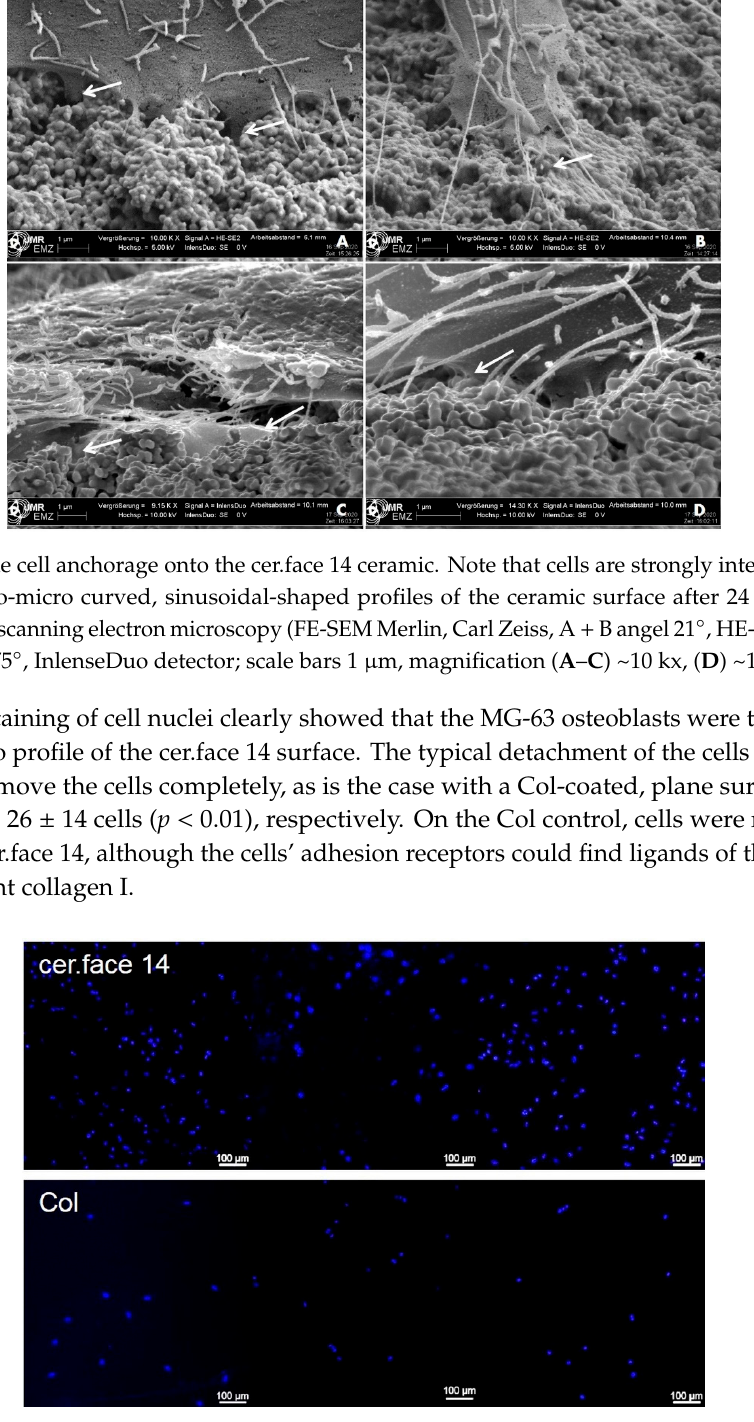
( b ) Figure 6. Reactive oxygen species (ROS): non/negligible stress level of osteoblasts on ceramic (cer.face 14), which is comparable with cells on the extracellular matrix protein collagen I (Col) ( a ) after 1 h, ( b ) after 24 h. Cells’ intracellular ROS level is ~9 times higher if stressed with H 2 O 2 as positive control. The amount of ROS in human osteoblasts MG-63 was detected via DCF-DA cellular ROS detection assay kit (Tecan Infinity 200). Statistics: one-way ANOVA posthoc uncorrected Fishers LSD, significance * p < 0.05, n = 3 (independent experimental approaches). Free intracellular ATP, as the universal energy carrier in the cells, also serves as an indicator of cellular stress. In order to further investigate possible cellular stress due to surface landscapes, the ATP level in cells on the structured cer.face 14 in comparison to the plane Col control was measured